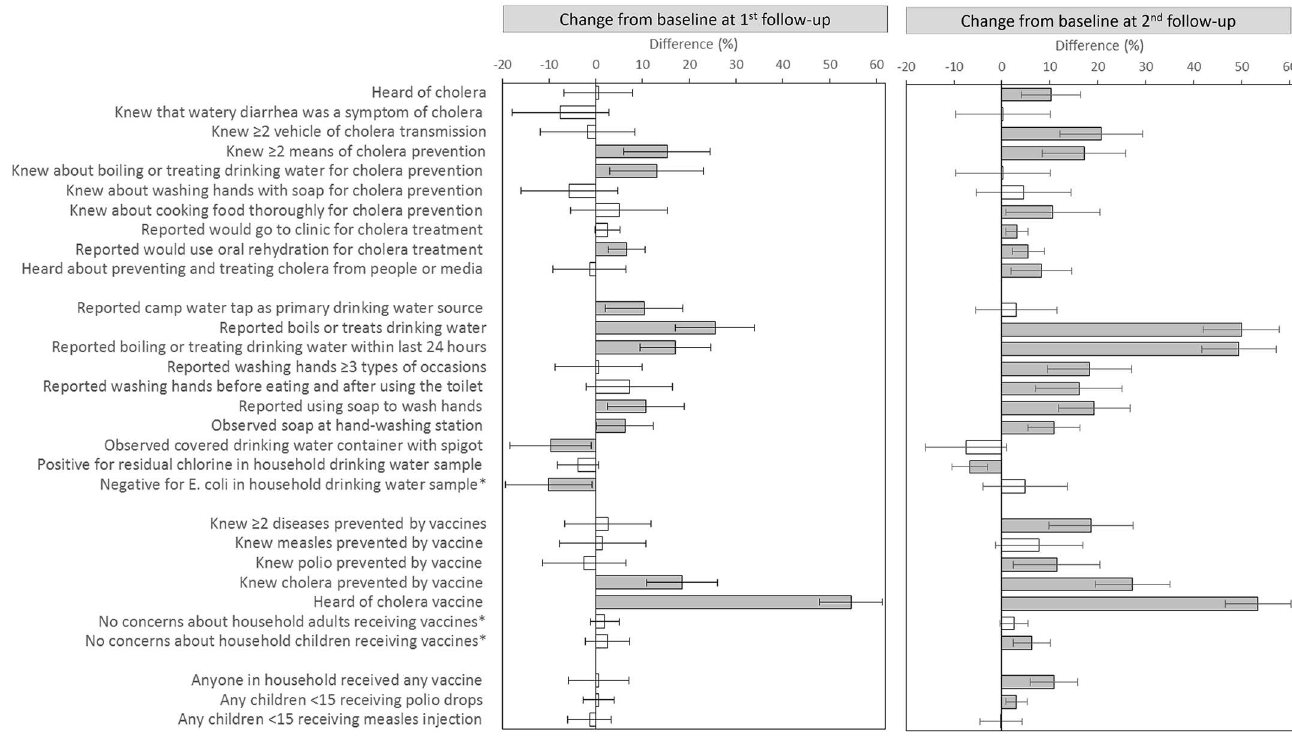
Fig 1. Differencesin knowledge, attitudes and practices(KAPs) for surveysconducted 1 month before (baseline) versus 3 and 12 months after (first and second follow-up) an oral cholera vaccination campaign in Maela Camp, 2013. Absolute differences in proportions for KAP responsesin the first and second follow-upsurveys comparedto baselinewere calculated; error bars depict 95% Wald asymptotic confidenceinterval (CI). Statistically significantdifferences (CI not overlappingzero) are shown in grey; non-significant differencesare shownin white. Outcomes marked with * have directionalityof difference switchedfrom Tables 3 and 4, so that improvements are depicted in positive direction, and negative changesare depicted in negativedirection.